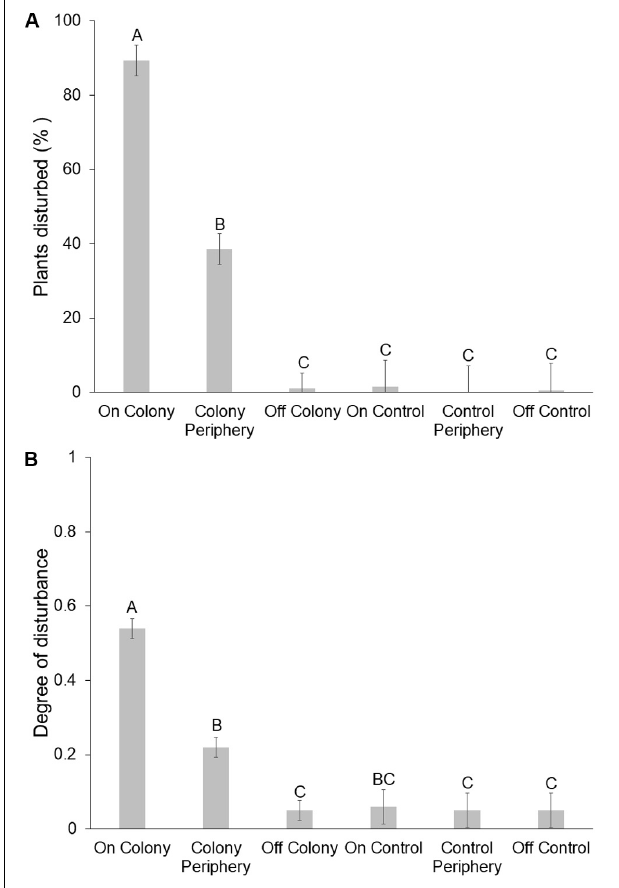
FIGURE 3 | Mean ( ± SE) percentage of “simulated” Prosopis velutina and Larrea tridentata saplings disturbed by black-tailed prairie dogs ( Cynomys ludovicianus ) (A) and scalar (0 = none; 1 = max) assessments of the degree of disturbance (B) on, on peripheries, and off of active colonies and a control site ( n = 16; see section “Materials and Methods”). Different letters above bars indicate significant ( P < 0.05) differences between means within a